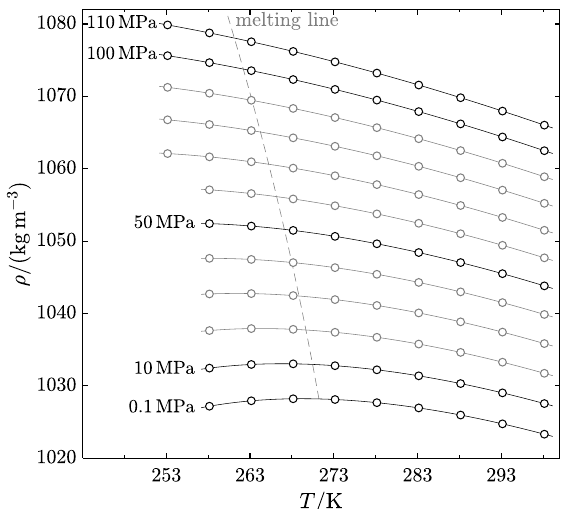
Fig. 5. Relative deviations of H 2 O densities from this work from densities calculated with IAPWS-95 formulation